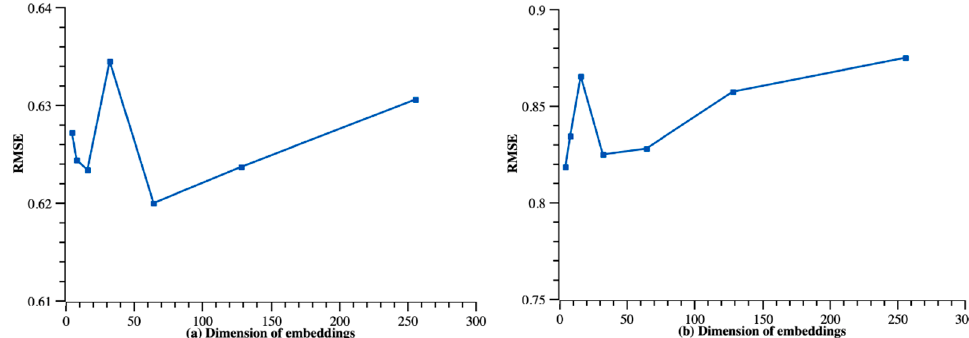
Figure 7. Root mean squared error (RMSE) of different dimensions of embeddings. ( a ) Experimental results on MovieTweetings-latest dataset; ( b ) Experimental results on DigitalMusic dataset.